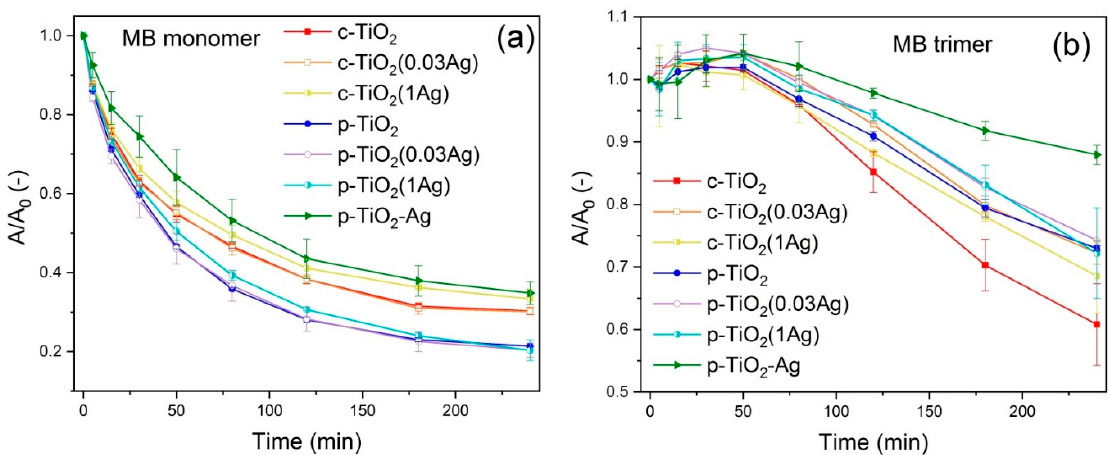
Figure 7. A/A 0 – t curves of methylene blue ( a ) monomer and ( b ) trimer degradation under UV light. The monomer photostability is much lower compared to the associated form, while trimerization also occurs during the UV irradiation.